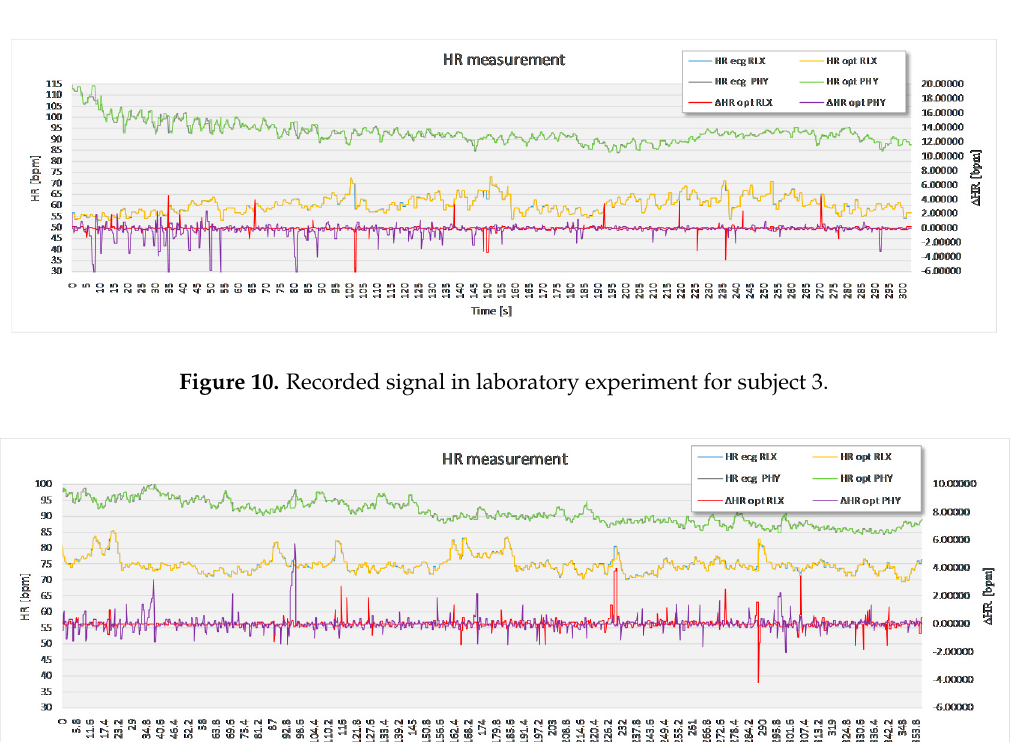
Figure 9. Recorded signal in laboratory experiment for subject 2.